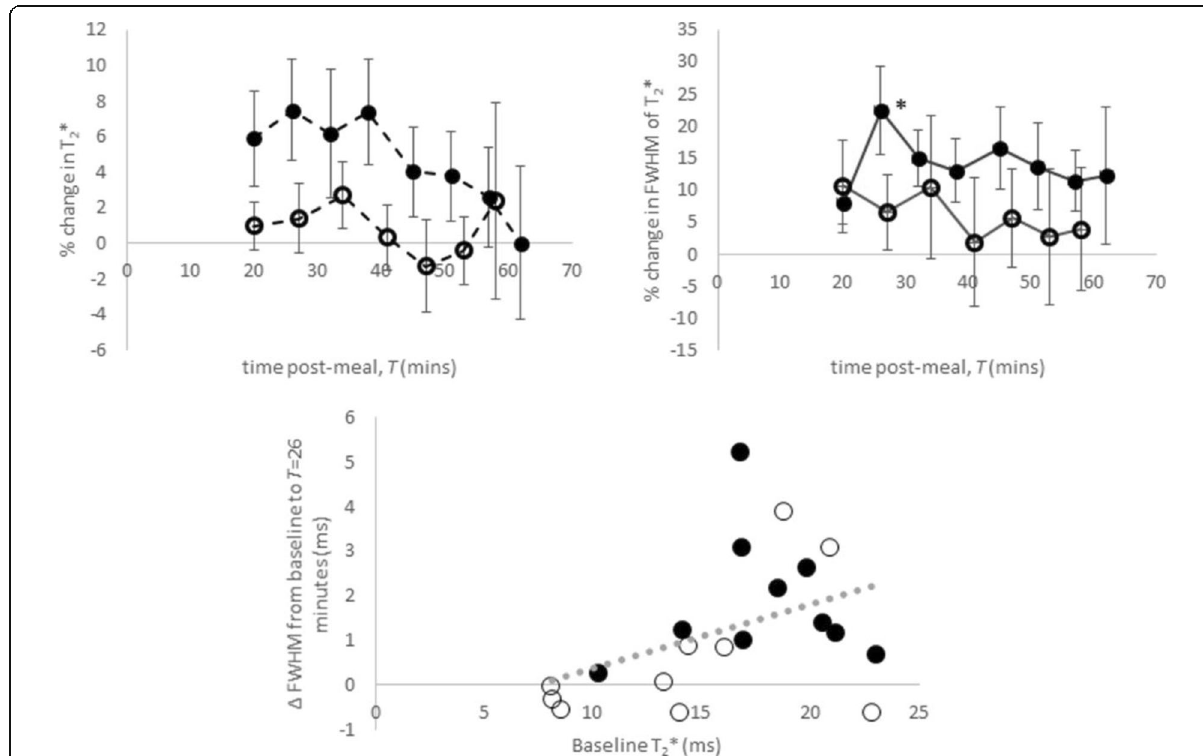
Fig. 6 Percentage change in transverse relaxation time (T2*) following meal ingestion in healthy participants and patients with compensated cirrhosis (CC) (mean ± standard error of the mean). Filled circles indicate healthy participants and open circles indicate patients with compensated cirrhosis. Comparison of each time point with baseline, * p <